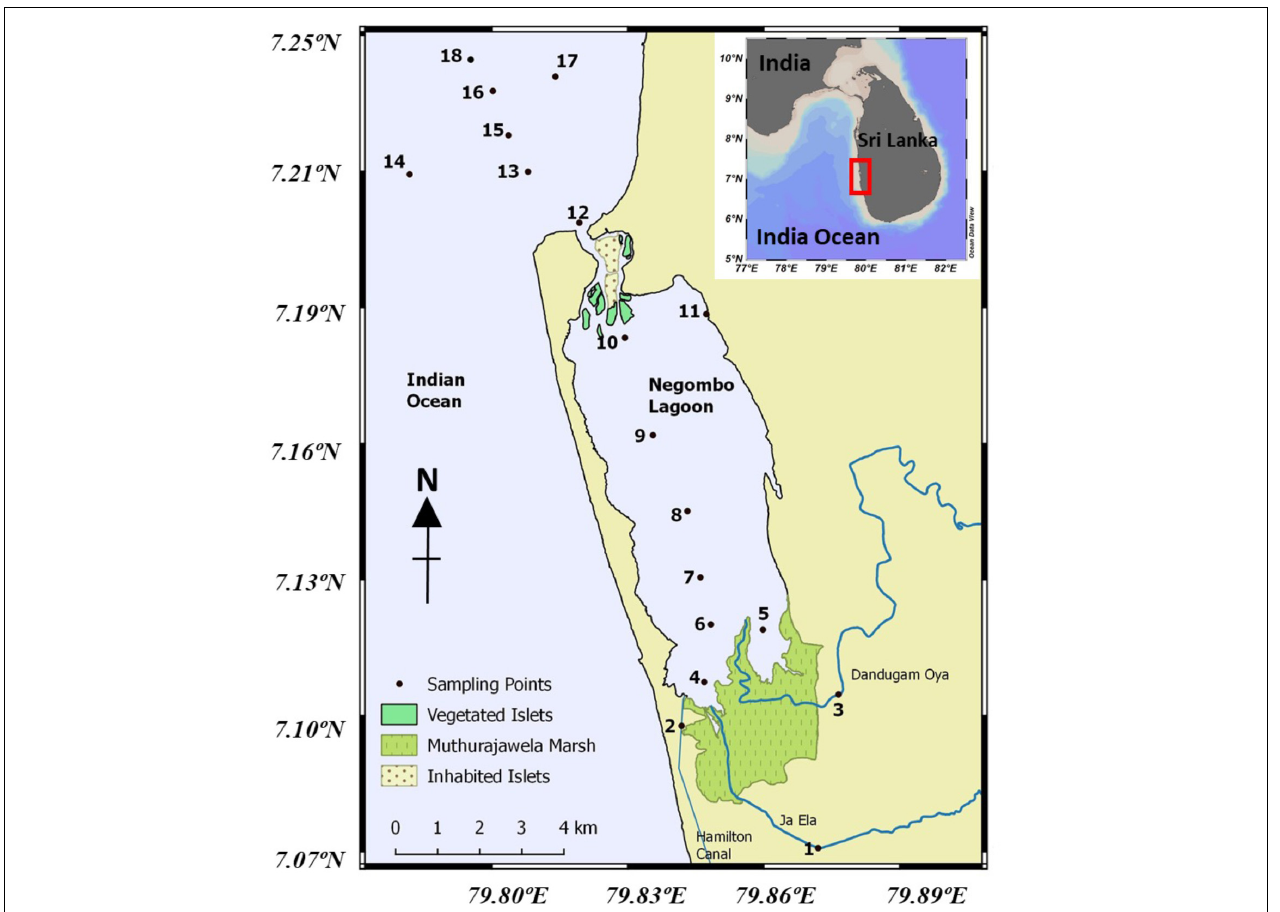
FIGURE 1 | Sampling locations in the Negombo Lagoon and the adjacent coastal